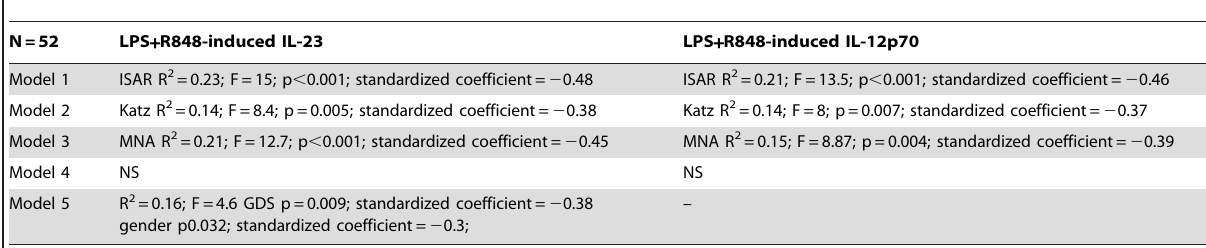
Table 4. Association between TLR response and frailty (N =52) : Multivariate analyses.